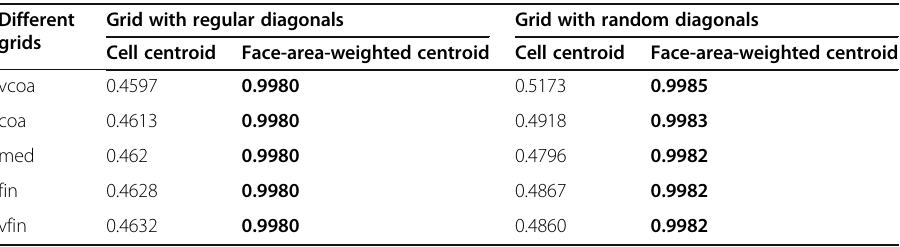
Table 7 Grid skewness measure of geometric centroid and face-area-weighted centroid on two grid types